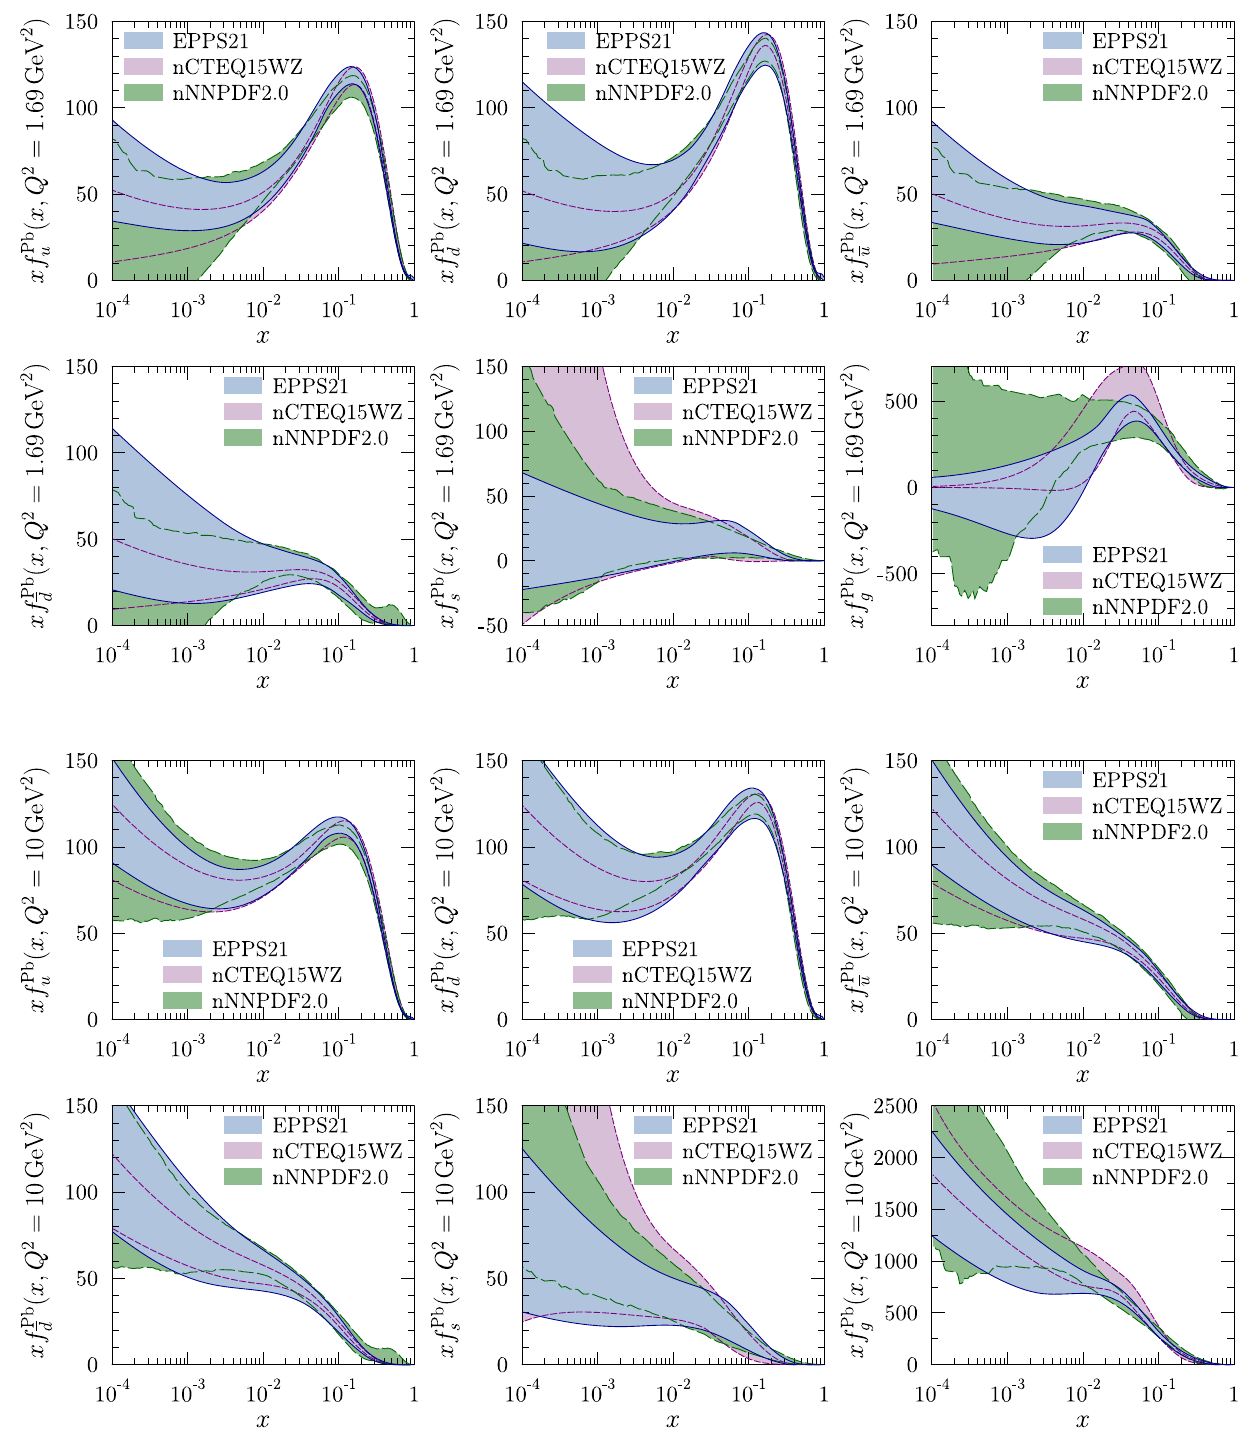
Fig. 12 The 90% confidence-level EPPS21 (blue), nCTEQ15WZ (purple) [94], and nNNPDF2.0 (green) [10] PDFs in lead at Q 2 = 1 . 69GeV 2 (upper panels) and at Q 2 = 10GeV 2 (lower